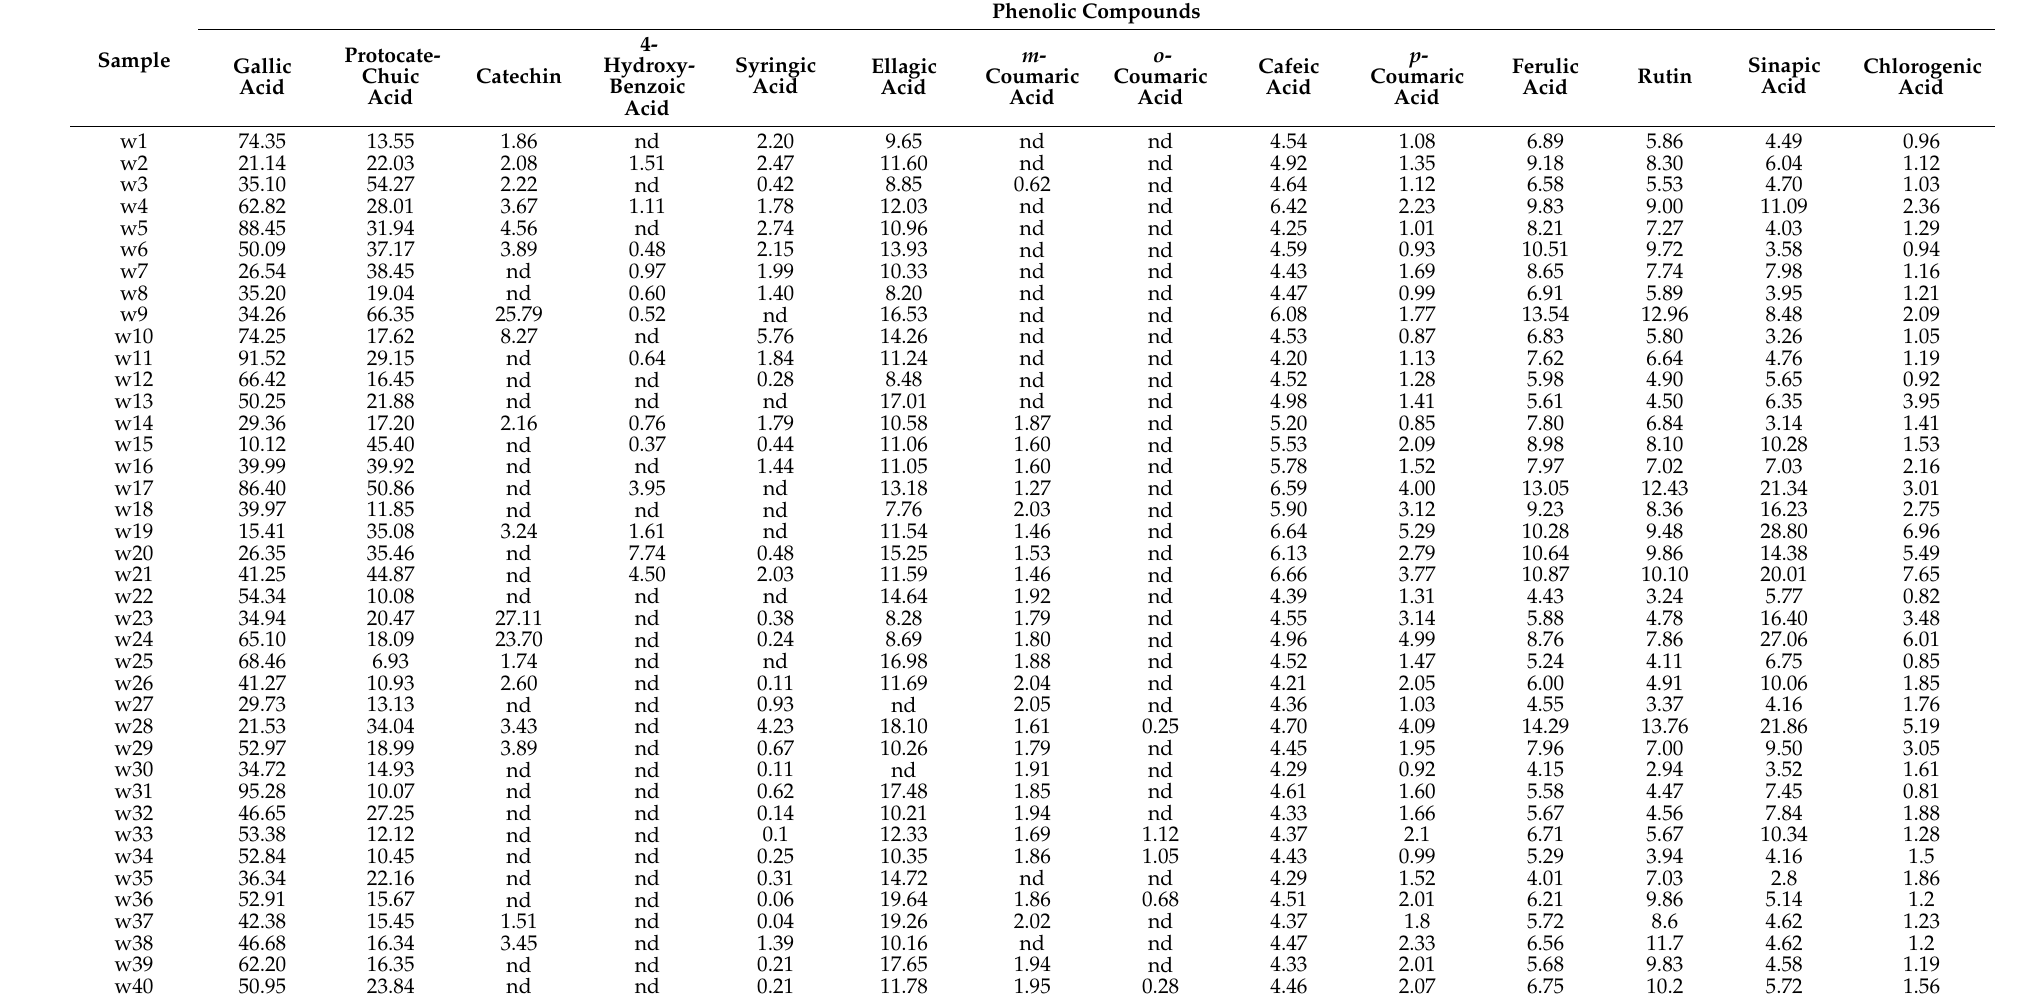
Table 3. Free phenolic compounds of purple wheat samples ( µ g/g of dry